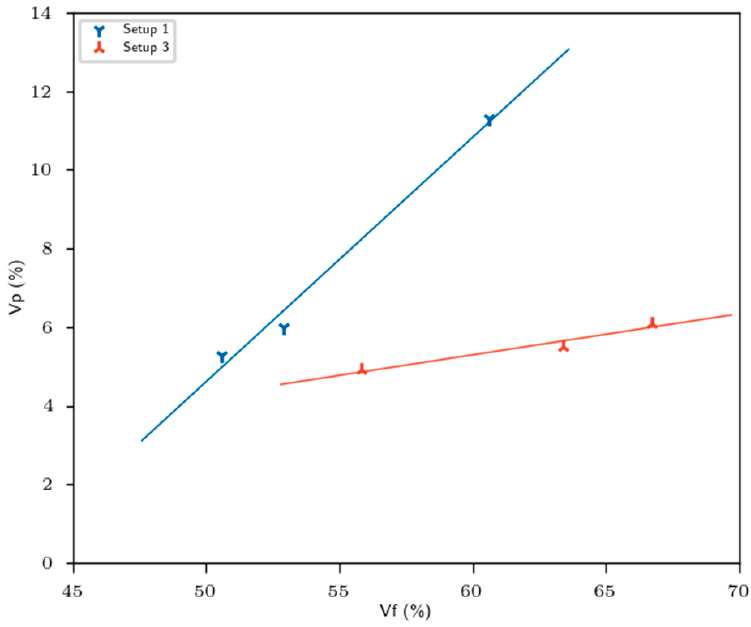
Figure 7. Variation of porosity rate in function of fiber rate .